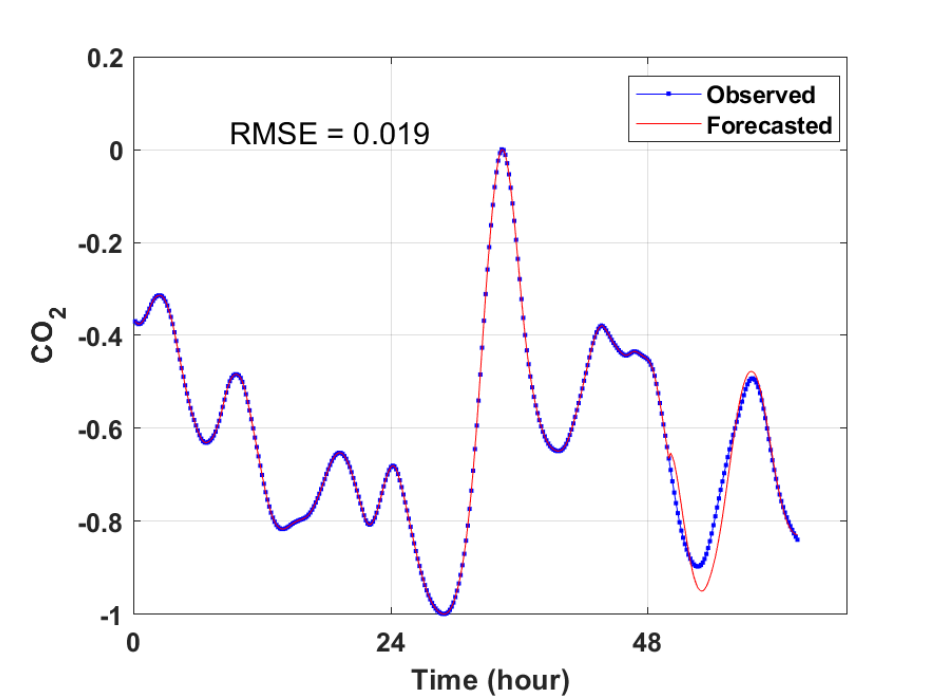
Figure 11. CO 2 forecasting by PSO-LSTM.